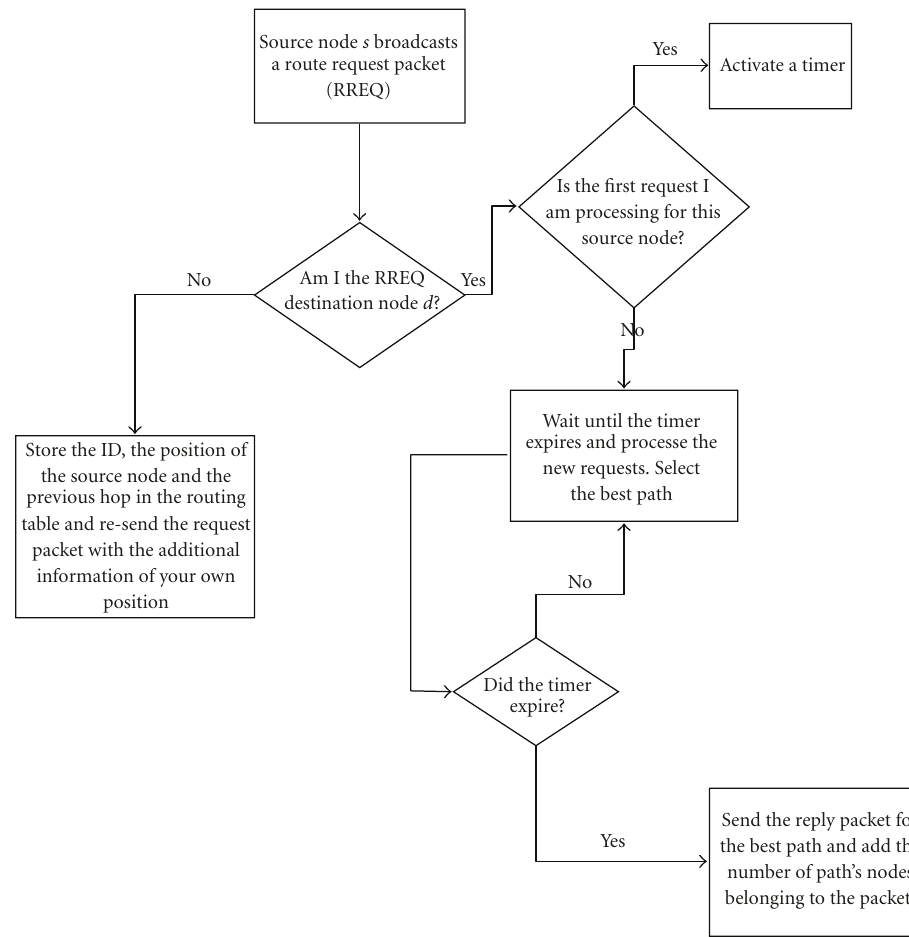
Figure 2: Routing Request phase of